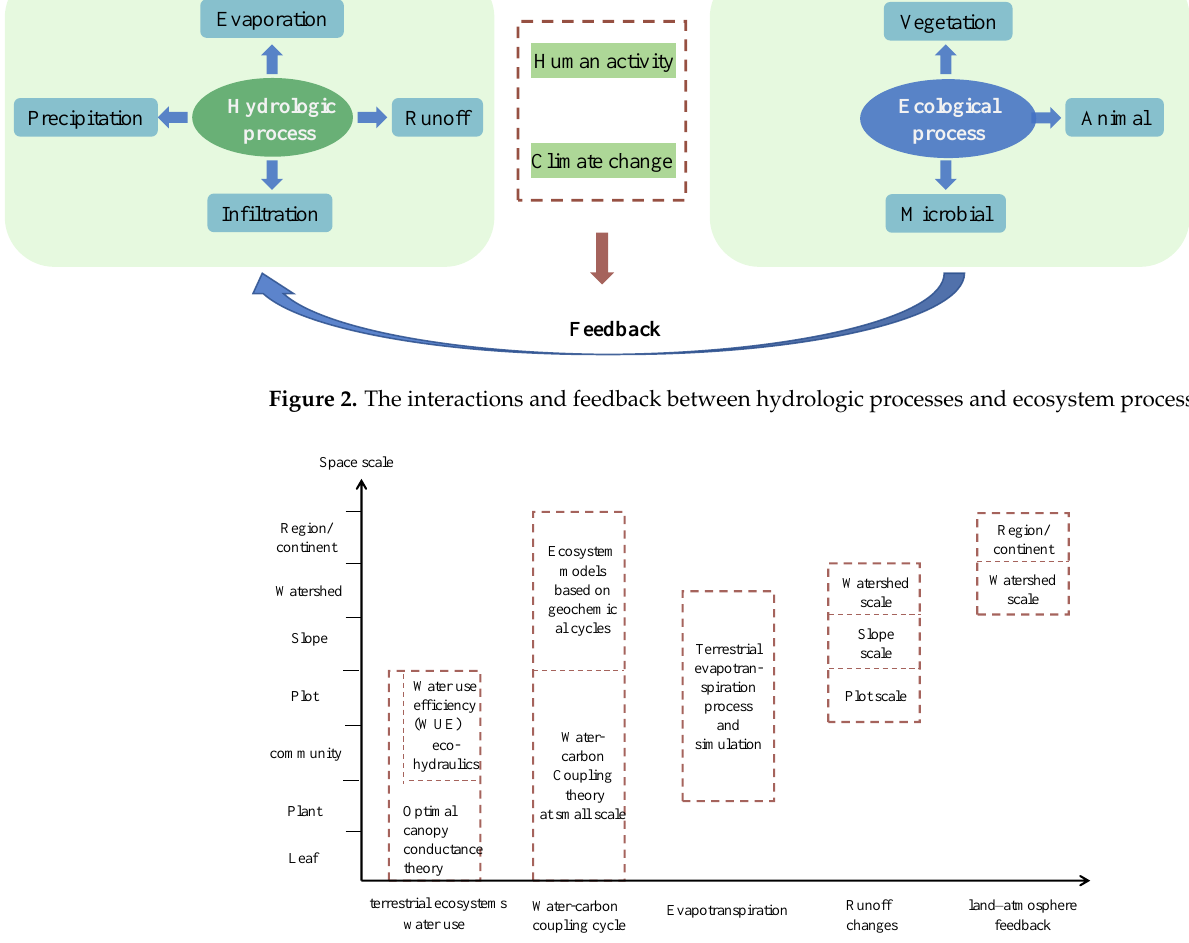
Figure 3. Research hotspots and spatial scales of ecohydrological processes. Adapted with permission from Ref. [40]. 2021, Genxu Wang.